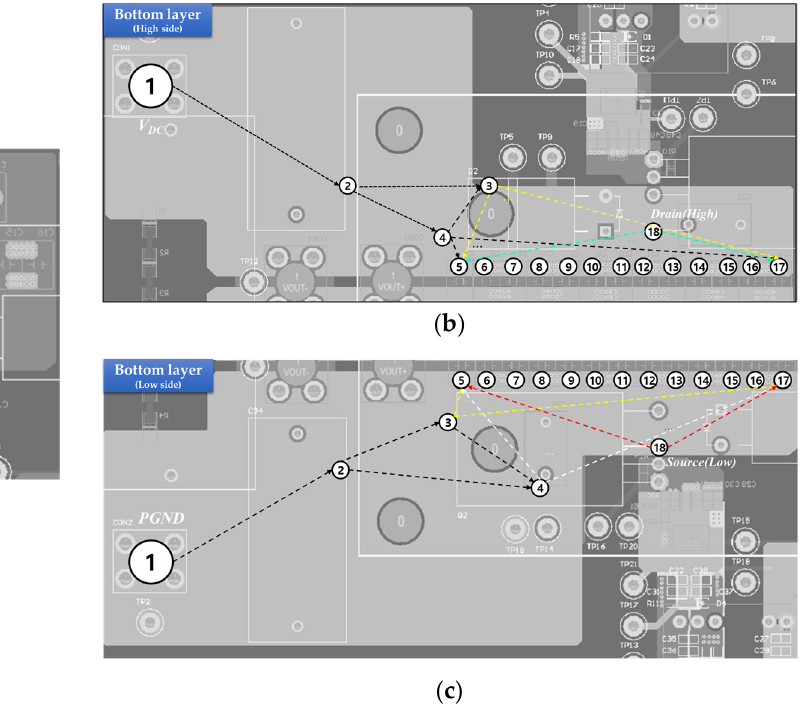
Figure 14. The simplified essential points from Figure 8b,c. ( a ) Top layer. ( b ) Bottom layer of high side. ( c ) Bottom layer of low side.